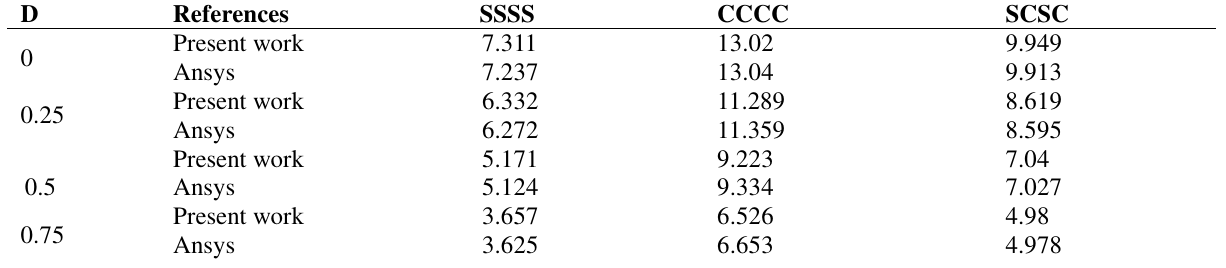
Dimensionless natural